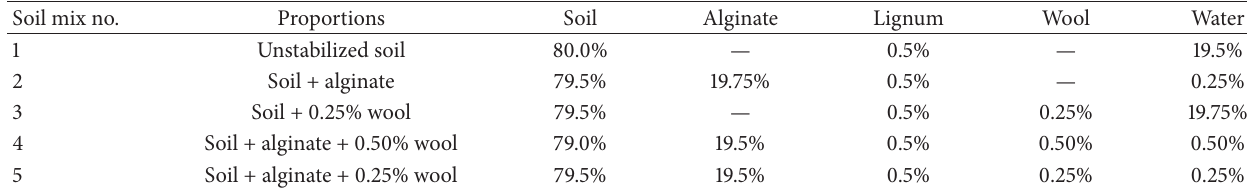
Table 2: Mixes used (by weight).